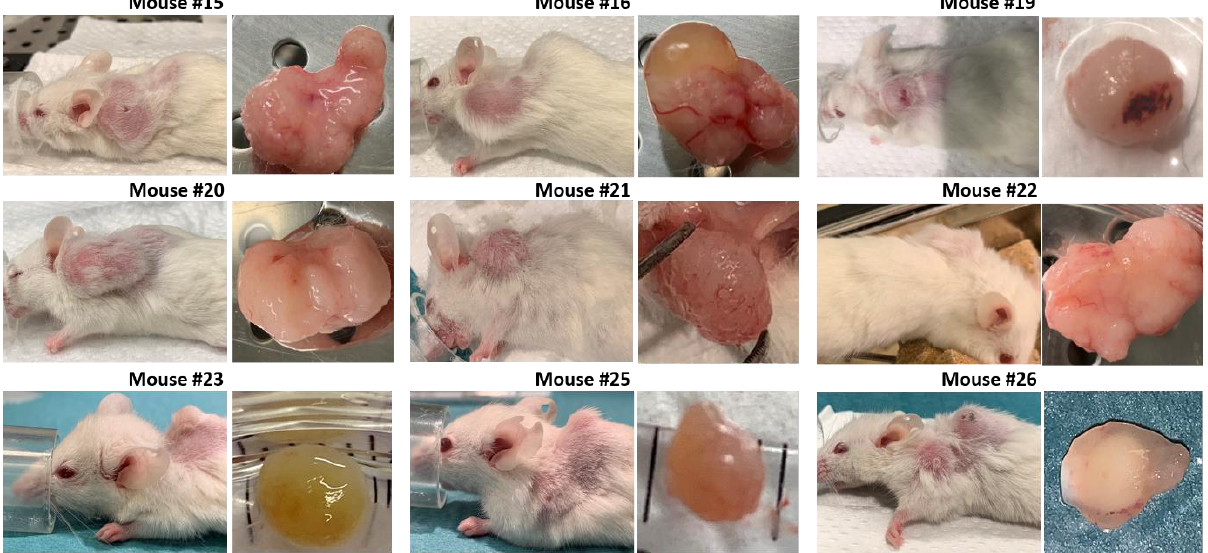
Figure 10. Images of 9 of 10 established PDXs, taken at the day of euthanization. Mouse #17 died during the anesthetic procedure (isoflurane) when assessing tumor size and the tumor was not sampled.